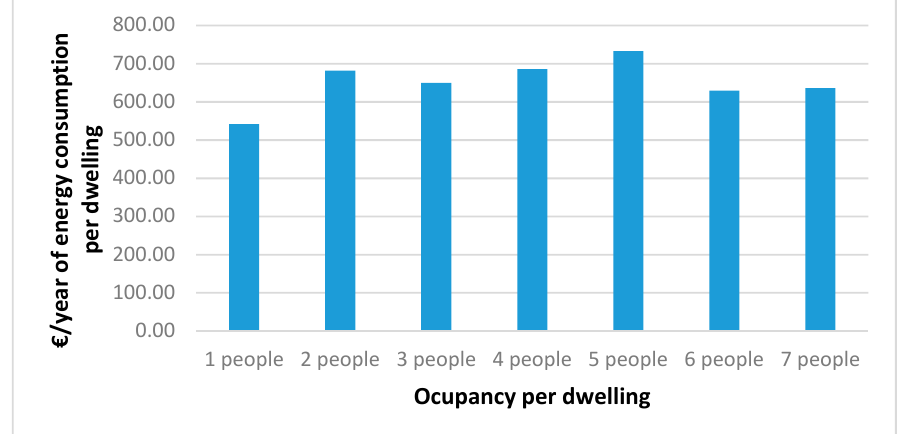
Figure 7. Monthly heating demand (kWh per month) for several levels of air changes per hour for a dwelling in building B. Buildings 2018 , 8 , 11